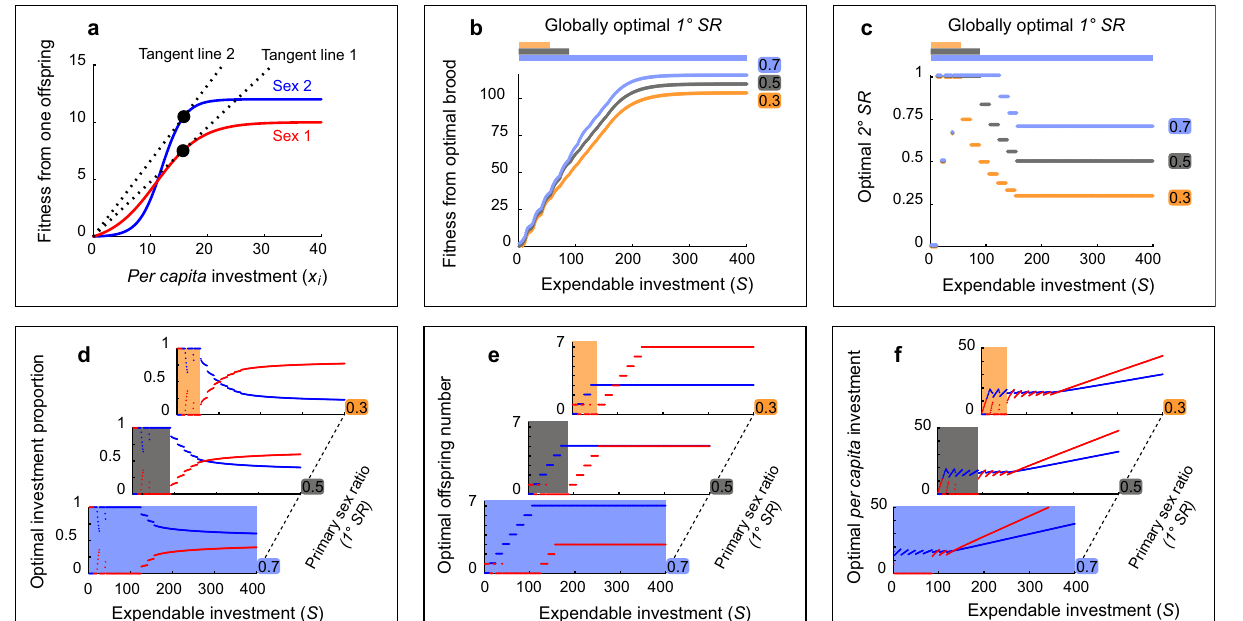
Fig. 4 The results from model M5 (fully presented in Fig. S5), in which the tangent line of Sex 2 is steeper than that of Sex 1 . The predictions are inconsistent with the classical TWH. Panels represent the same information as in panels from Fig. 3. In this model, the reversed TWH predictions are observed: Sex 1 offspring (red lines) receive most investment at high parental expendable investment ( S ) for equal or Sex - 1 -biased primary sex ratios, despite having a lower variance in fi